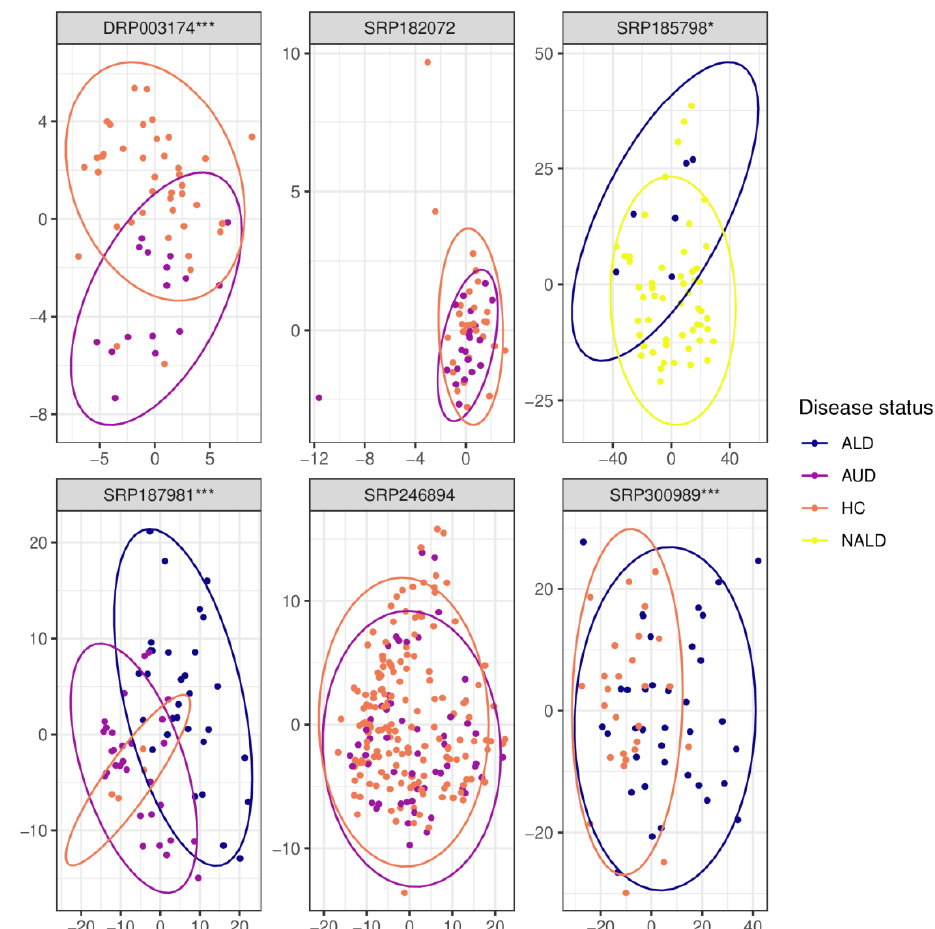
Figure 5. Principal coordinate analysis (PCoA) plots of beta-diversity measured with Euclidean distance after normalization using PhilR. The label above each graph indicates the SRA identifier for the corresponding dataset; ALD — alcoholic liver disease, AUD — alcohol use disorder, HC — healthy controls, NALD — other, non-alcoholic liver disease, * — p <= 0.05, *** — p < = 0.001.